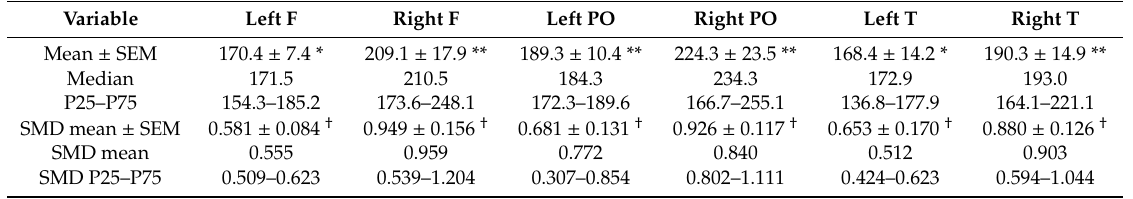
Table A2. Changes in power of theta bands during GS.